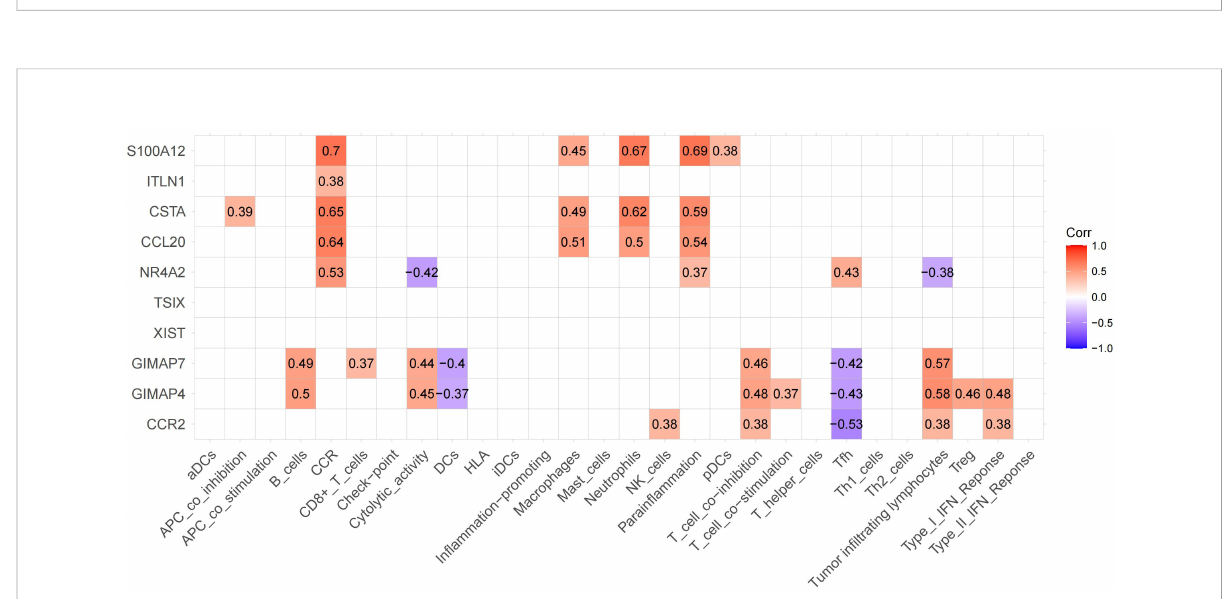
FIGURE 7 Expression of signi fi cant genes associated with immune functions. The upregulated and downregulated correlations are displayed in red and purple, respectively. We labeled these 6 genes as hub